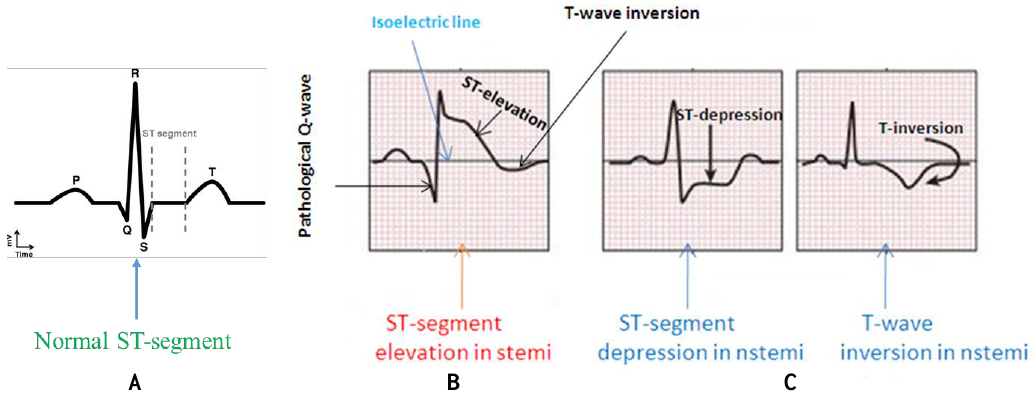
Figure 1. Comparison of the ST-segment variations in a normal subject ( A ) and in MI patients with ST-elevation myocardial infarction (STEMI) ( B ) and non-ST-elevation MI (NSTEMI) ( C ).